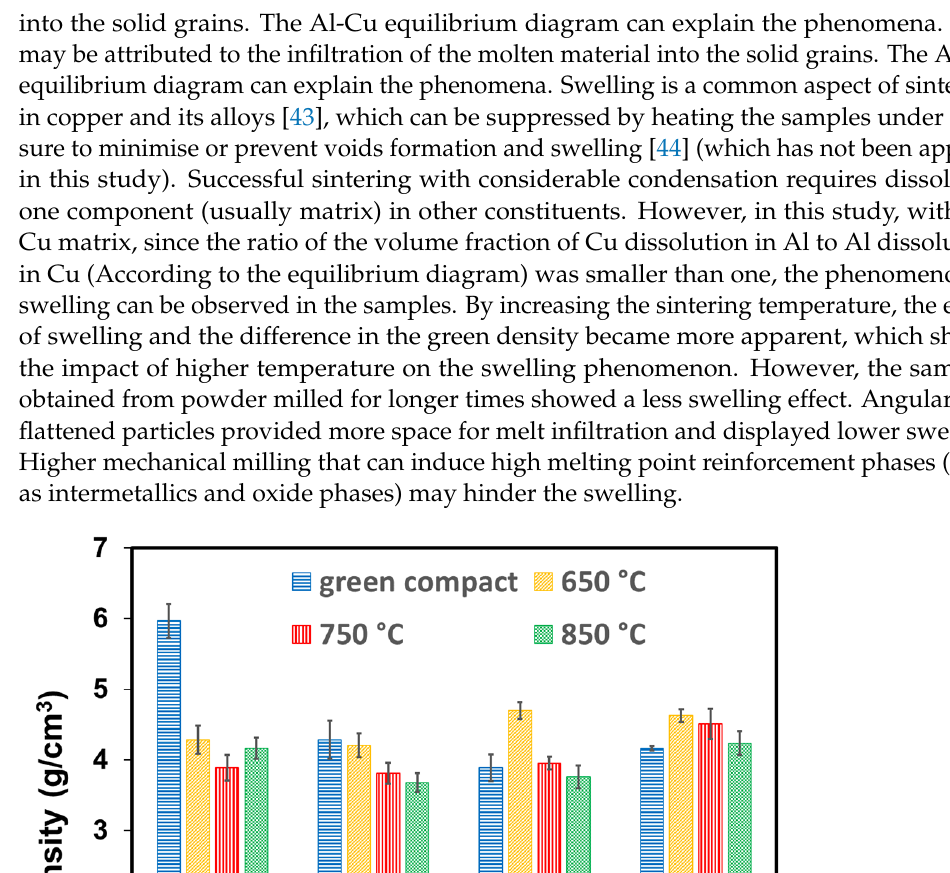
Figure 10. The hardness of sintered samples.